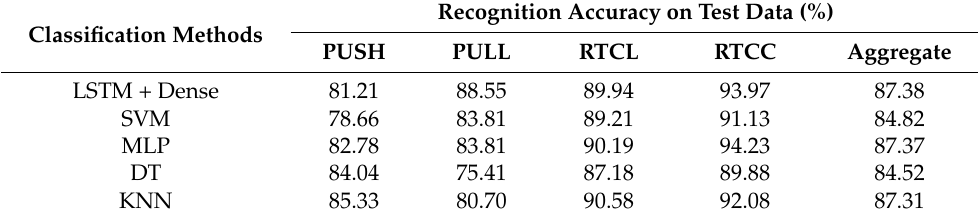
Table 1. Recognition rate of different classification methods.